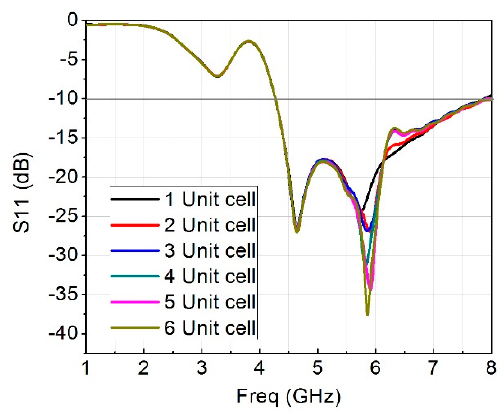
Figure 2. S11 plot for various quantity of metamaterial unit cell.